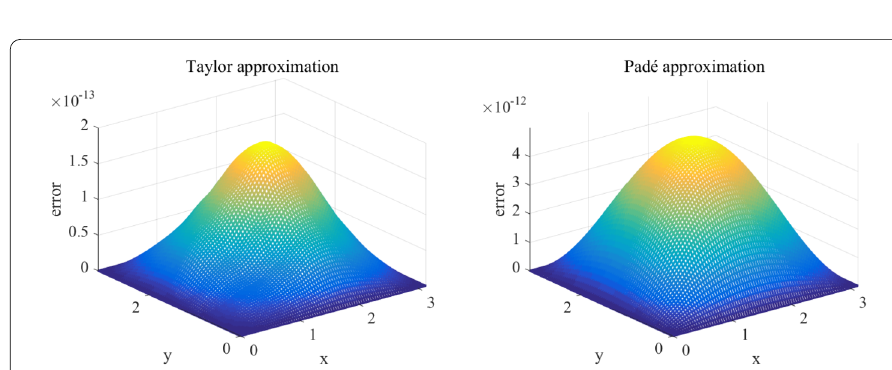
Figure 17 The errors between the exact solutions and CFDS-PIM approximated solutions of the Taylor approximation (on left-hand side figure) and the errors between the exact solutions and CFDS-PIM approximated solutions of Padé approximation (on right-hand side figure) for two-dimensional problem at t = 1 with N = 81 × 81 for Example 5